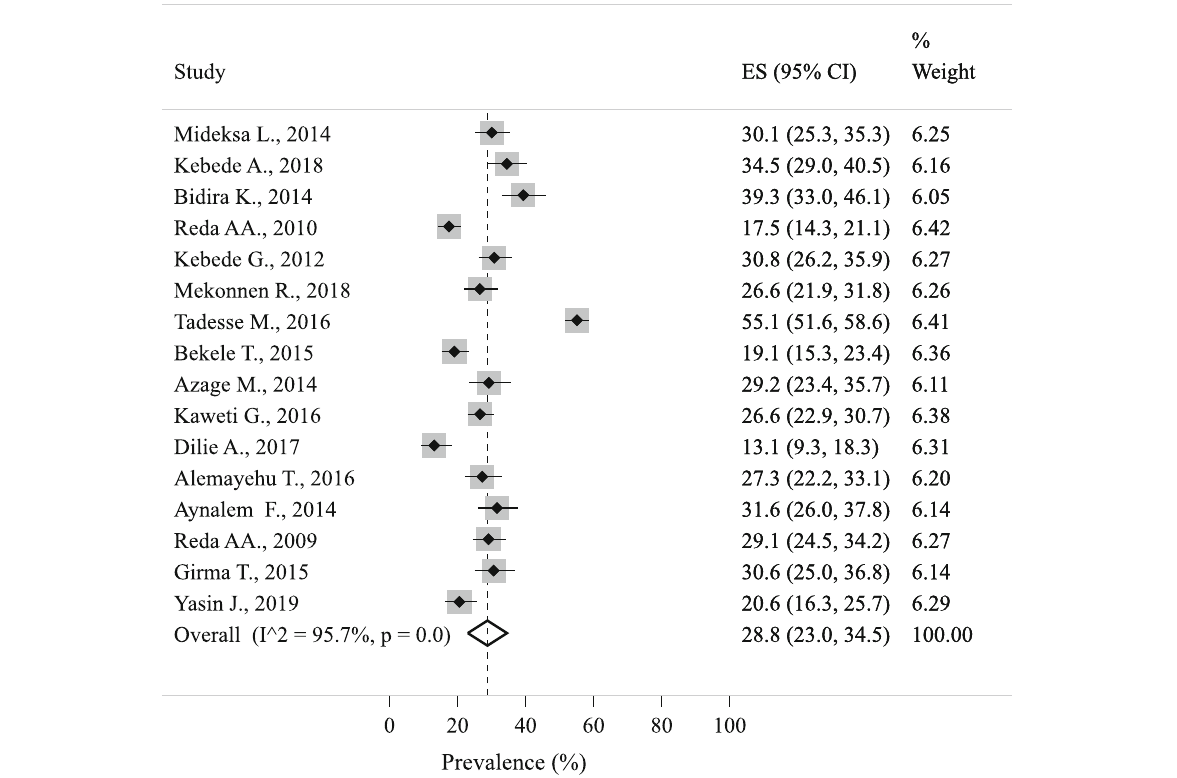
Fig. 2 The 12-month prevalence of needlestick injuries among the Ethiopian healthcare